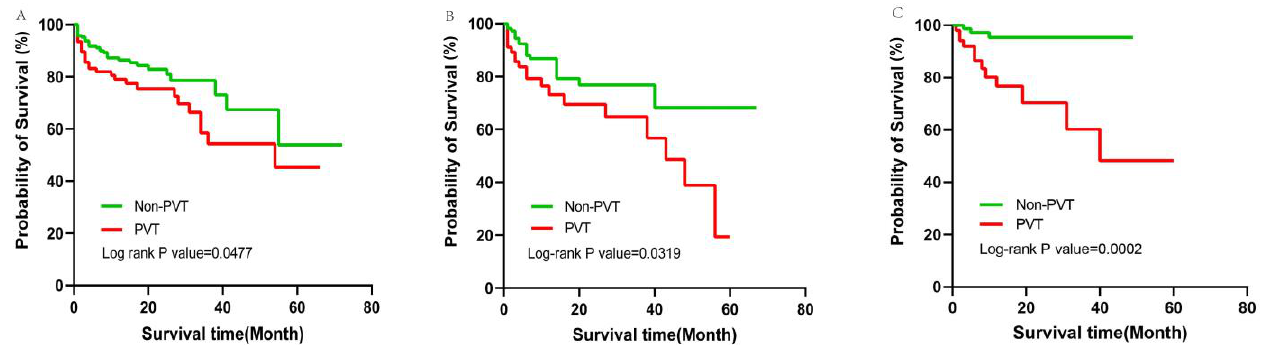
Figure 5. Kaplan–Meier curves in training cohort ( A ), internal validation cohort ( B ), and external validation cohort ( C ). The red line represents the PVT group, and the green line represents the non-PVT group. The X -axis indicates the survival time, and the Y -axis indicates the probability of survival. Table 4. Incidence of severe complications during the follow-up.